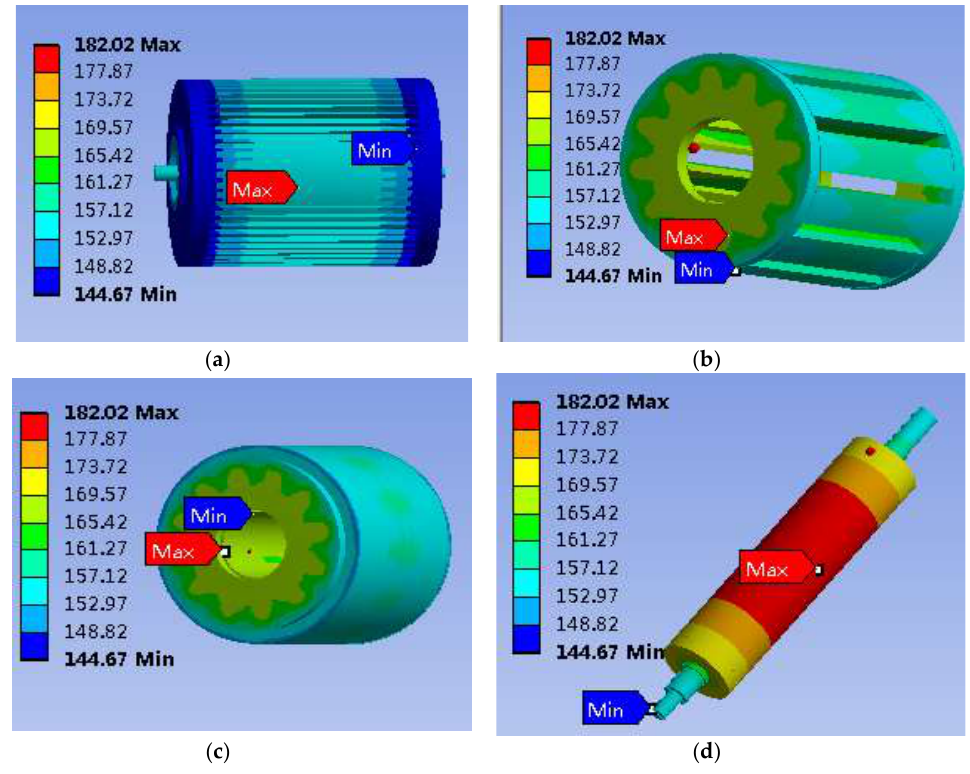
Figure 10. Temperature distribution of the initial motor, ( a ) Temperature distributon of motor; ( b ) Temperature distributon of motor winding; ( c ) Temperature distributon of stator; ( d ) Temperature distributon of rotor. Energies 2018 , 11 , x FOR PEER REVIEW